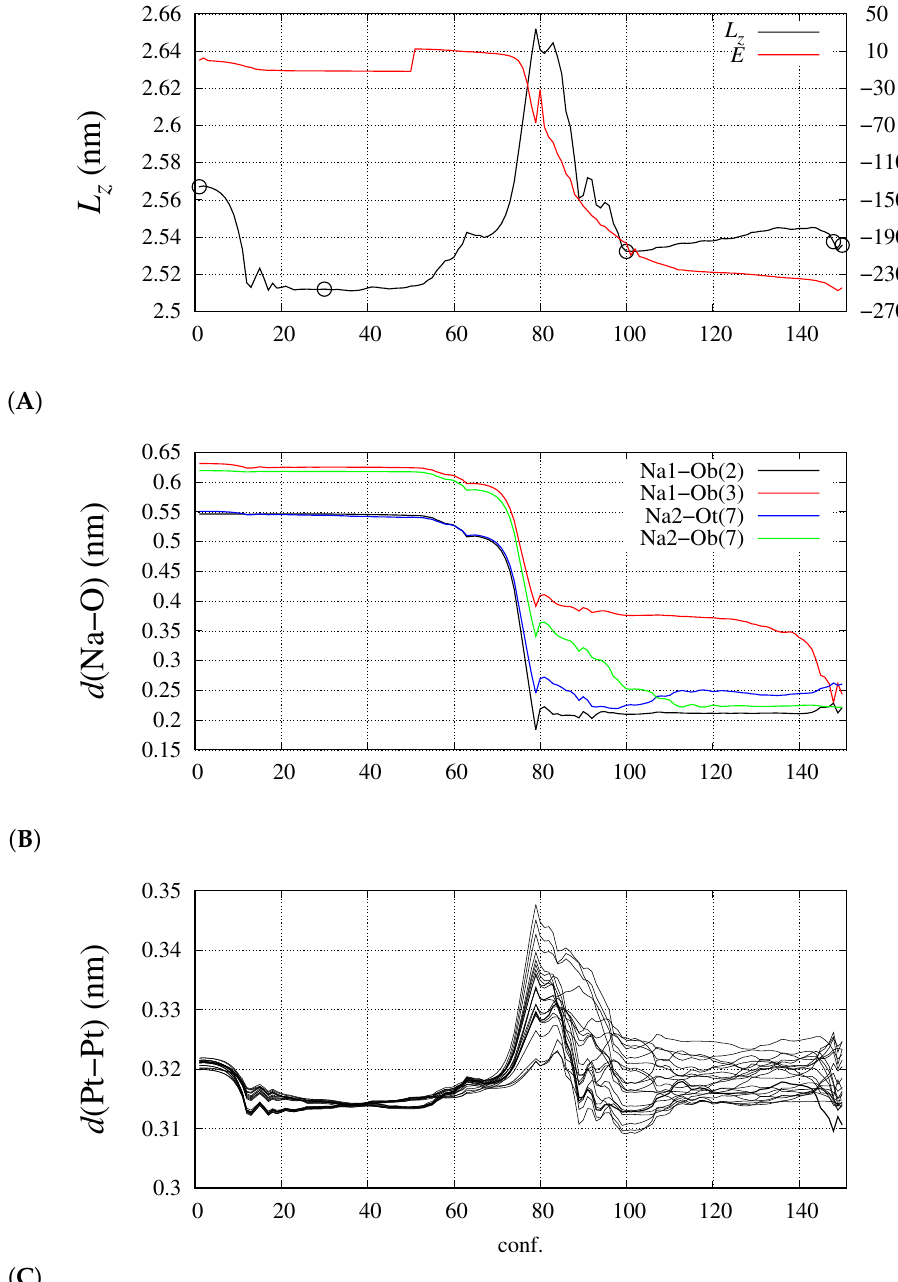
Figure 6. Evolution of geometrical parameters of the nano-wire along with the variable-cell energy minimization. The first 50 configurations are obtained with Na atoms fixed in space. Panel ( A )—cell length along the z direction ( L z , left axis) and total energy ( E , right axis, zero is for the initial value); circles emphasize the configurations analyzed in Figure 8; panel ( B )—distances between the two Na atoms and the closest O atoms of the nano-wire (the monomer number is indicated within brackets); panel ( C )—inter-monomer shortest Pt